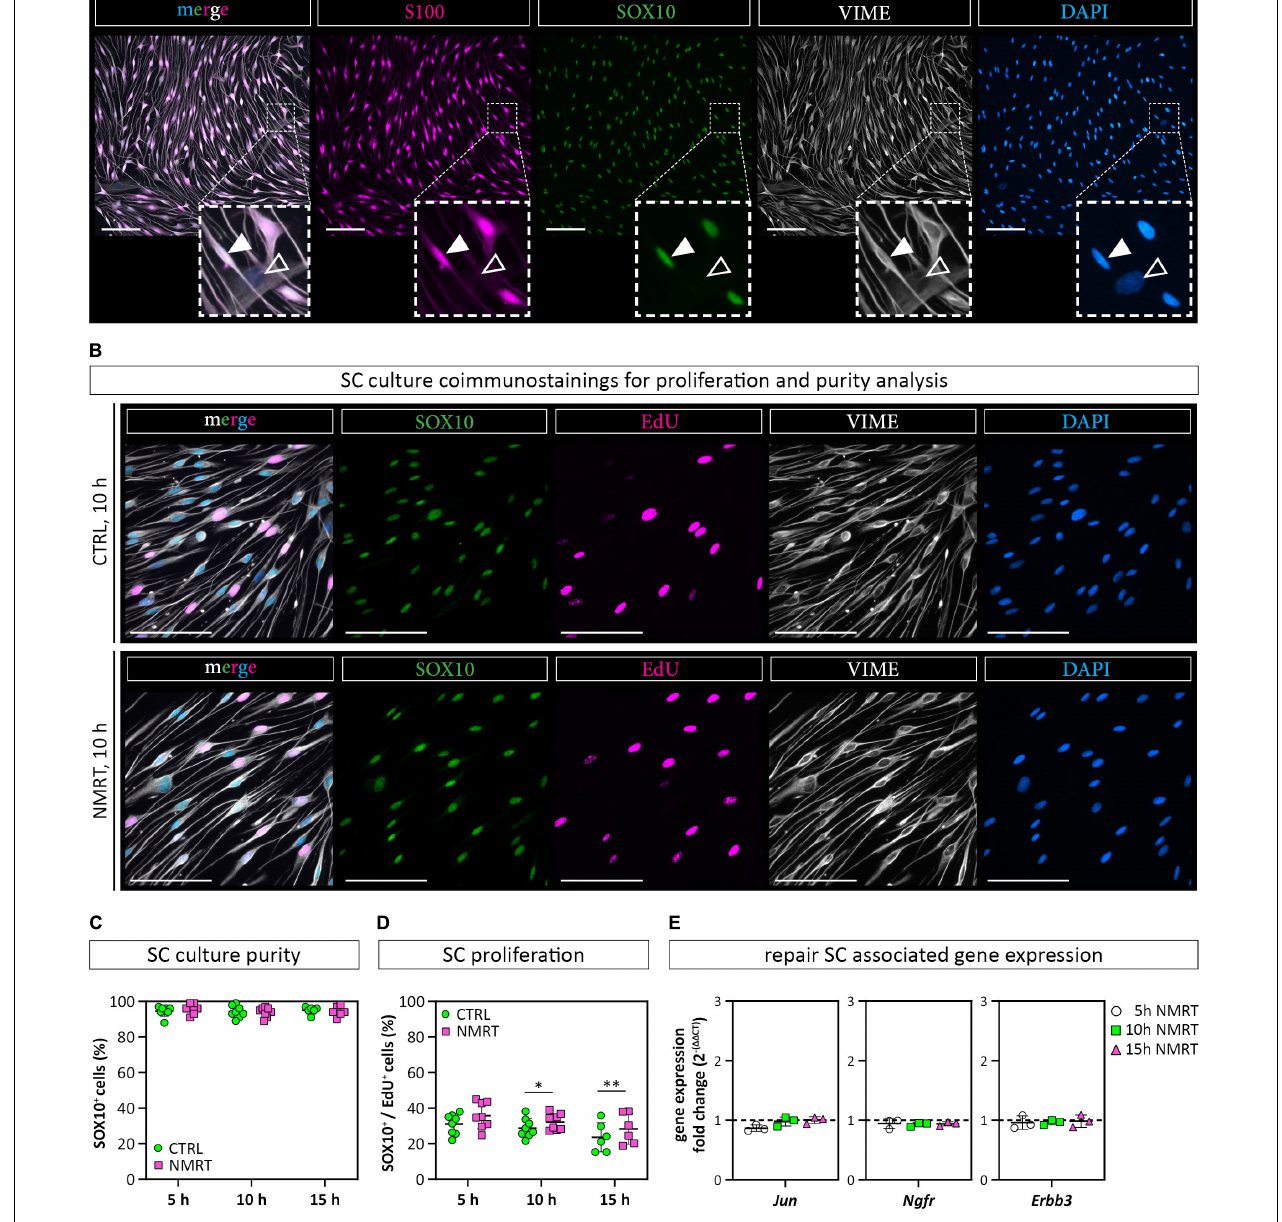
FIGURE 4 | Comparison of SC behavior in response to NMRT. (A) Representative fluorescence images of a primary SC culture stained for SC markers SOX10 (green) and S100 (magenta) as well as intermediate filament vimentin (VIME, white) and DAPI (blue); filled arrowheads indicate a SOX10 + /S100 + /VIME + /DAPI + SC, lined arrowheads indicate a SOX10 − /S100 − /VIME + /DAPI + fibroblast. Scale bars represent 100 µ m. (B) Representative fluorescence images of control SC cultures (upper panel) and NMRT treated SC cultures (lower panel) after the 10 h NMRT treatment cycle stained for SC marker SOX10 (green), proliferation marker EdU (magenta), VIME (white) and DAPI (blue). Scale bars represent 50 µ m. Representative fluorescence images after the 5 and 15 h treatment cycles are shown in Supplementary Figure 2 . (C) SC culture purity was calculated in percent of SOX10 + /DAPI + cells (SCs) from DAPI + cells (all cells) and showed no difference between the NMRT and CTRL condition; data are depicted as single values for each donor ± SD ( n = 6). (D) Proliferating SCs were calculated in percent of SOX10 + /EdU + /DAPI + cells (proliferating SCs) from SOX10 + /DAPI + cells (SCs) showing an increase of EdU + SCs in NMRT treated cultures after the 10 and 15 h treatment cycle compared to respective controls; data are depicted as single values for each donor ± SD, 5 h ( n = 8), 10 h ( n = 8), 15 h ( n = 6), two-way ANOVA, ∗ p < 0.05, ∗∗ p < 0.01. (E) Diagrams show the RT-PCR results of repair SC associated genes Jun , Ngfr , and Erbb3 as the gene expression fold change [2 − ((cid:49)(cid:49) CT ) ] between NMRT treated and control samples; data are depicted as single values for each donor ± SD ( n = 3), two-way ANOVA.